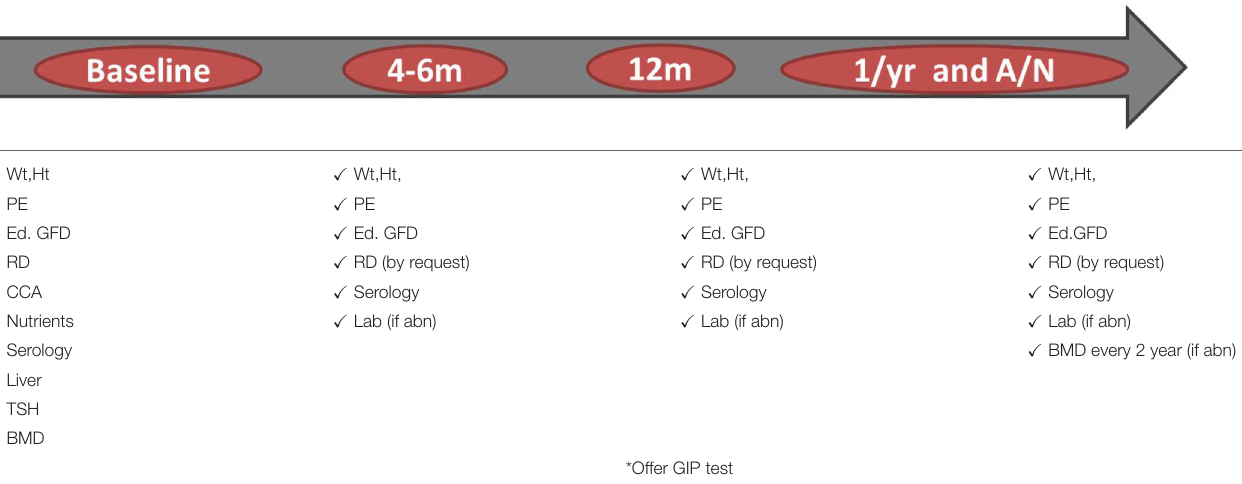
TABLE 3 | Recommended follow up for patients with